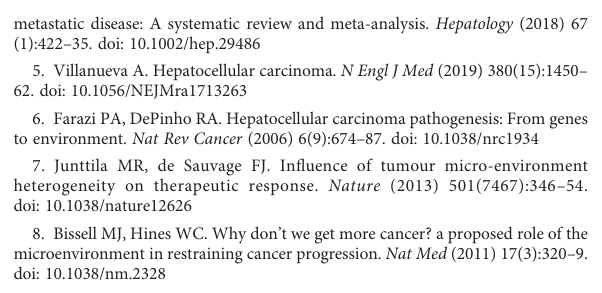
fi mmu.2022.951529/full#supplementary-material SUPPLEMENTARY FIGURE 1 The CNV of m5C regulator genes in TCGA-LIHC. SUPPLEMENTARY FIGURE 2 TClusteringofHCCbasedon18m5Cregulators.(A).Theconsensusscore matrix of all samples when k = 2. A higher consensus score between two samples indicatestheyaremore likelytobegrouped intothesamecluster in different iterations. (B). The cumulative distribution functions of the consensus matrix for each k (indicated by colors). (C-D). The best number of clusters k = 2, calculated by Silhouette algorithm (C) and R package “ NbClust ” (D). (E). PCA plot by the expression of 18m5C regulator genes in the two m5C clusters. The blue dots represented Cluster1, and the red dots represented Cluster2. (F). tSNE plot by the expression of 18 m5C regulator genes in two m5C clusters. The blue dots represented Cluster1, and thereddots representedCluster2. (G,H) Kaplan-Meier analysisfor OS (G) and PFS (H) of two m5C clusters in the TCGA-LIHC cohort. SUPPLEMENTARY FIGURE 3 Multivariate Cox analysis of training cohort TCGA-LIHC. SUPPLEMENTARY FIGURE 4 (A, B) Kaplan-Meier analysis for OS (A) and time-dependent ROC curve (B) of the risk score in the GSE14520 cohort. (C, D) Kaplan-Meier analysis for RFS (C) and time-dependent ROC curve (D) of the risk score in the GSE14520 cohort. SUPPLEMENTARY FIGURE 5 Immune cell in fi ltration by CIBERSORT(A), TIMER(B) and MCPcounter(C) between high- and low-m 5 C score groups. SUPPLEMENTARY FIGURE 6 Immunophenoscore (IPS) between high- and low- m 5 C score groups. SUPPLEMENTARY FIGURE 7 Validation of risk score in immunotherapy cohorts and other TCGA digestive cancers. (A-H) Kaplan-Meier curves for patients with high- and low- m5C scores in three immunotherapy cohorts IMvigor210 cohort (A), Riaz et al., Cell 2017 (B), Lauss et al., Nat Commun 2017 (C), and other TCGA digestive cancer cohorts included TCGA-PAAD (D), TCGA-CHOL (E), TCGA-STAD (F), TCGA-COAD (G), and TCGA-READ (H). SUPPLEMENTARY FIGURE 8 Differential expression of six selected genes in HCC and adjacent non tumor liver tissues in Xiangya HCC